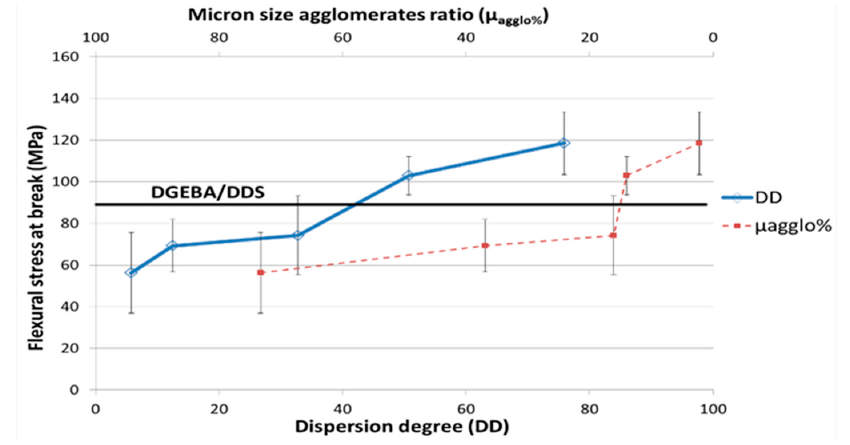
Figure 9. Young’s modulus as a function of MWNT dispersion degree in the DGEBA/DDS/MWNT nanocomposites (0.7 wt %).